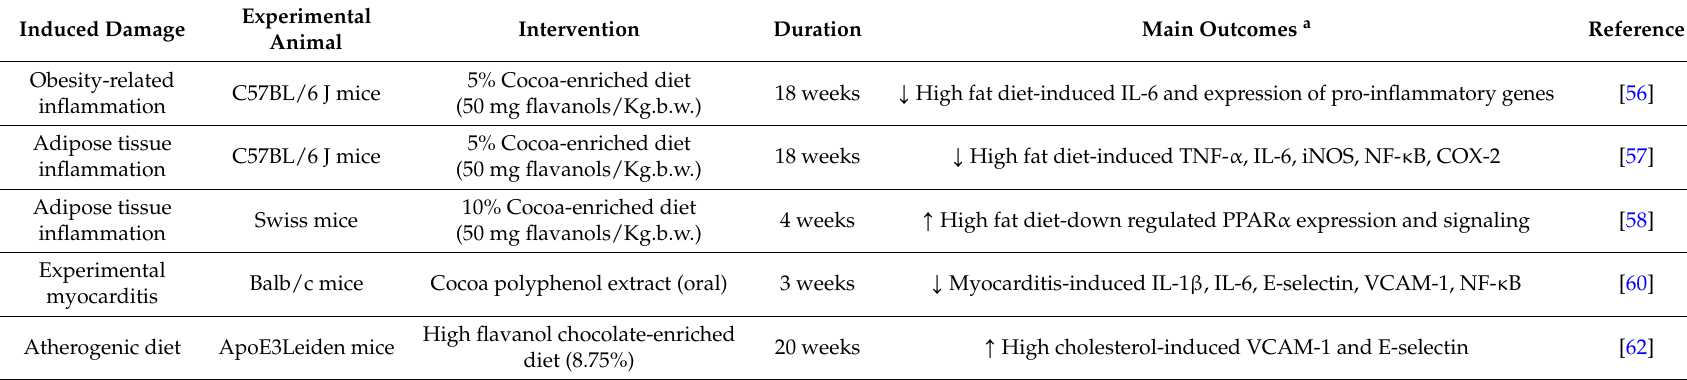
Table 2. Summary of recent data of the effects of cocoa and cocoa flavanols on inflammation markers in animal models of high-risk cardiovascular disease. Induced